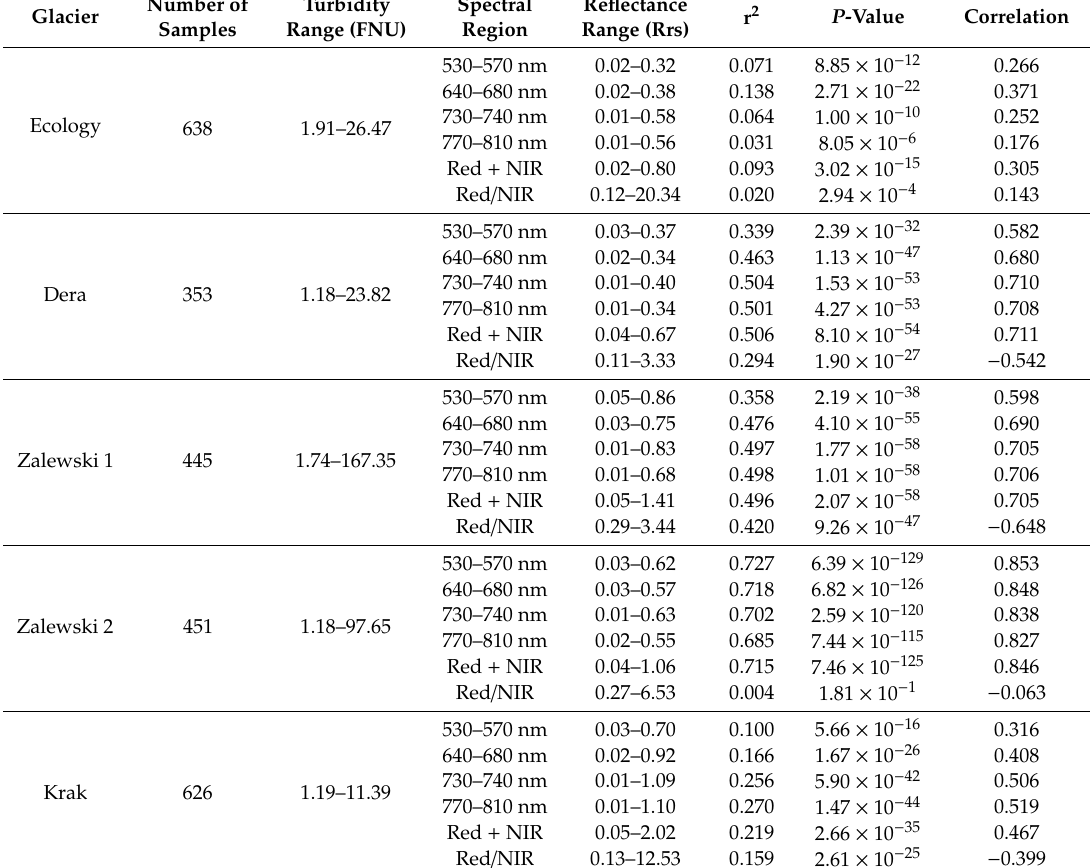
Table 4. Water turbidity and remote sensing reflectance (Rrs)